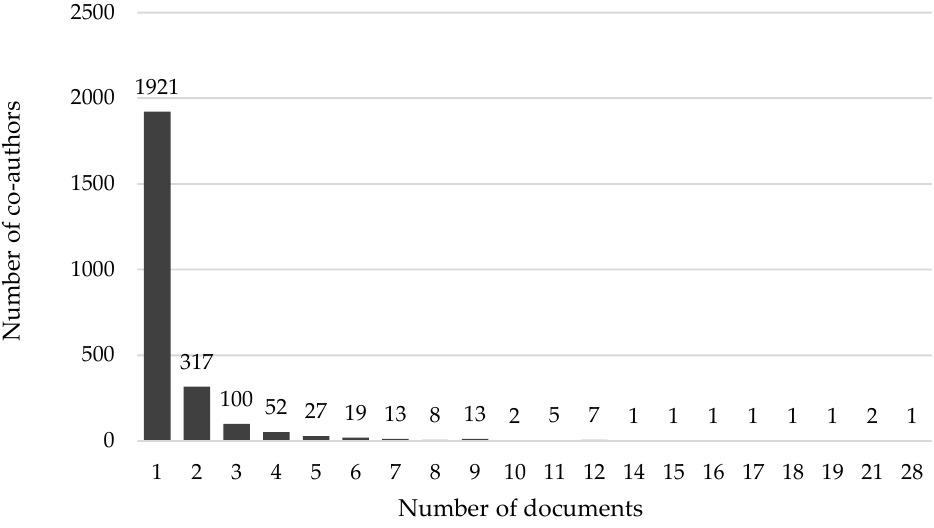
Figure 2. Distribution of co-authors according to the number of publications per co-author.